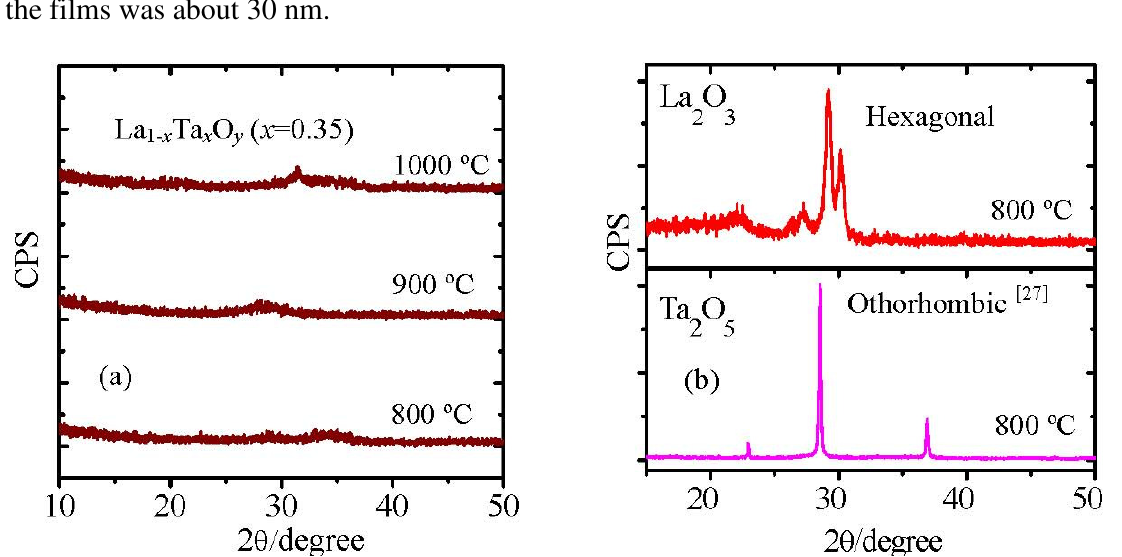
M O ternary metal oxides in the case of M 3+ . x y 1− x